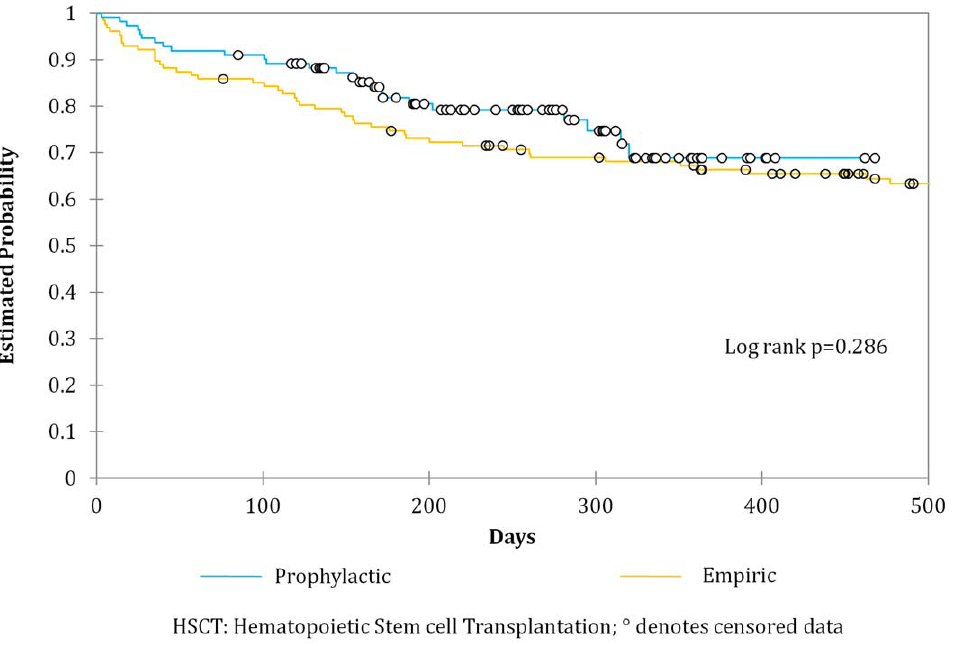
Figure 1. Overall survival of patients undergoing Hematopoietic Stem cell Transplantation receiving either a prophylactic or empiric antibiotic strategy.